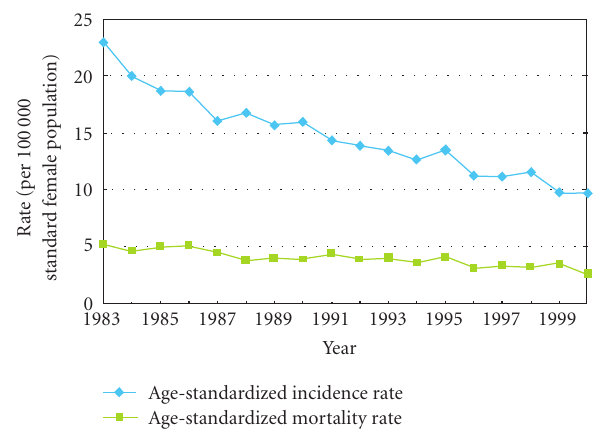
HONG KONG: CERVICAL CANCER SCREENING Annie NY Cheung